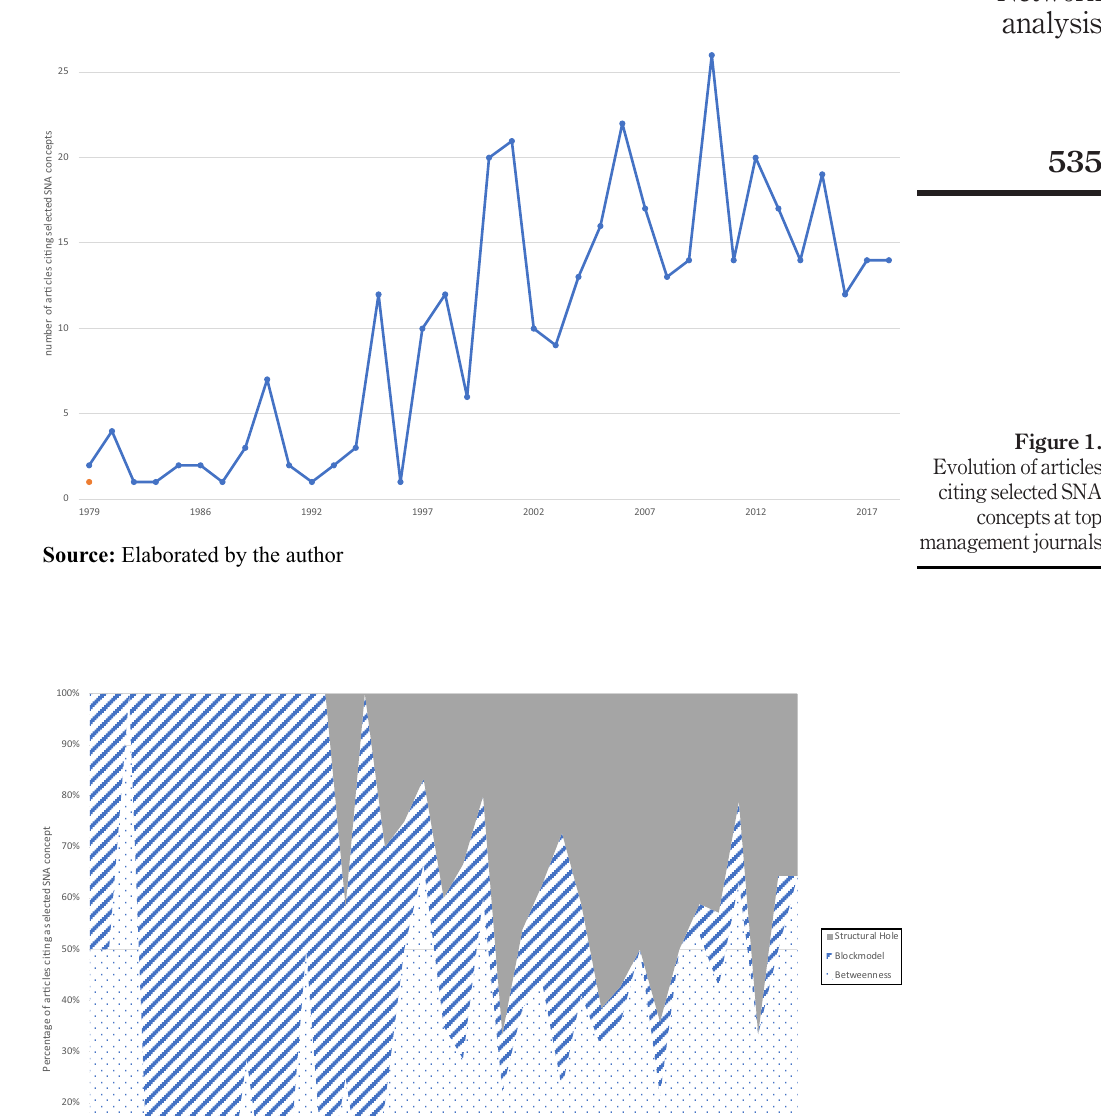
Figure 2. Percentage of articles citing selected SNA concepts at top management